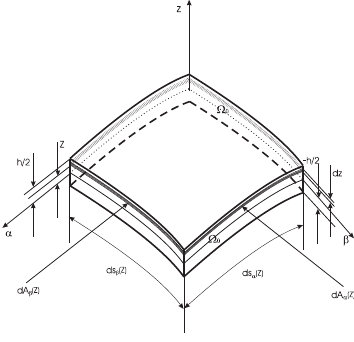
Figure 1: Geometry, notation and reference system for